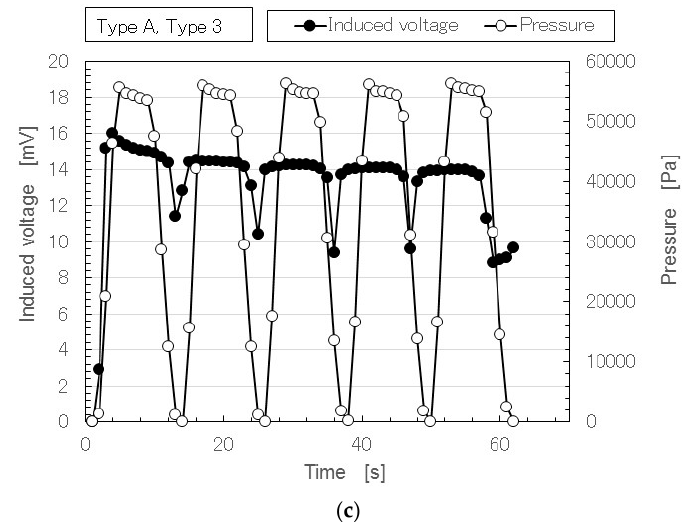
Figure 4. Typical results of time-lapse of induced voltage and pressure in the case of Type A. ( a ) Type 1; ( b ) Type 2; ( c ) Type 3.